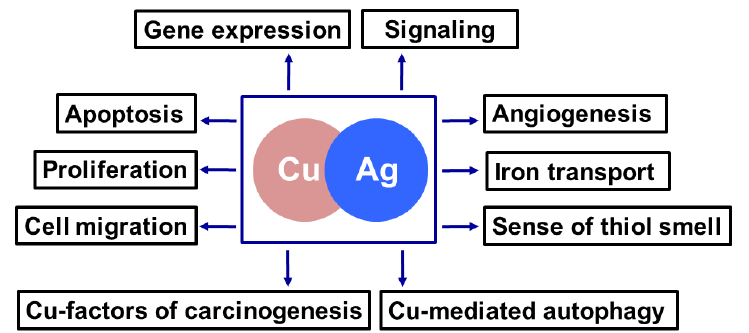
Figure 2. Copper-required cellular processes, in which Cu(I) can be replaced by Ag(I).